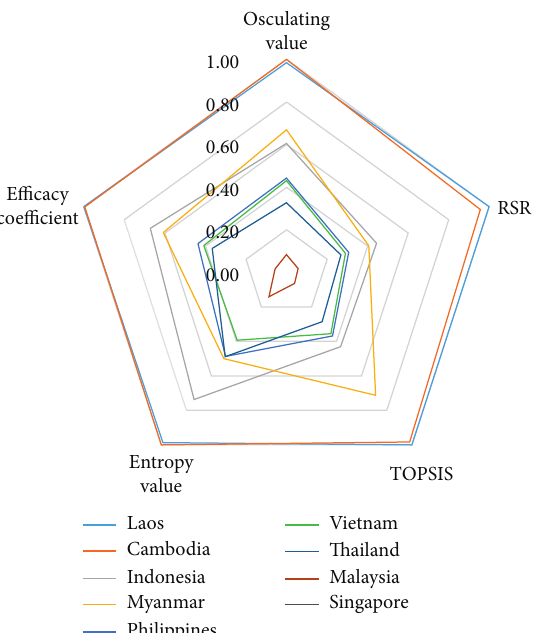
Figure 7: Matching effect picture of Chinese power companies in Southeast Asia. Table 4: Matching indicators value of Chinese power companies in Southeast